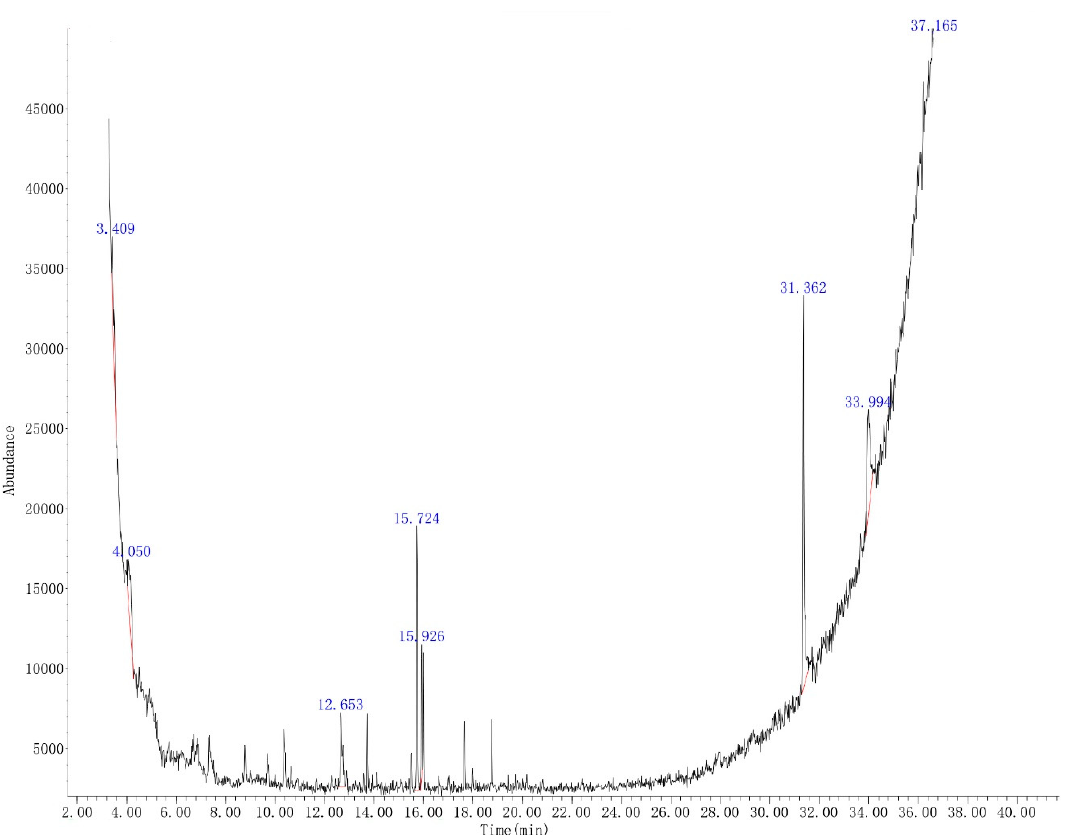
Figure 5. TIC of unregulated emissions absorbed by activated carbon in PPCI. Table 5. Exhaust components absorbed by activated carbon in PPCI.